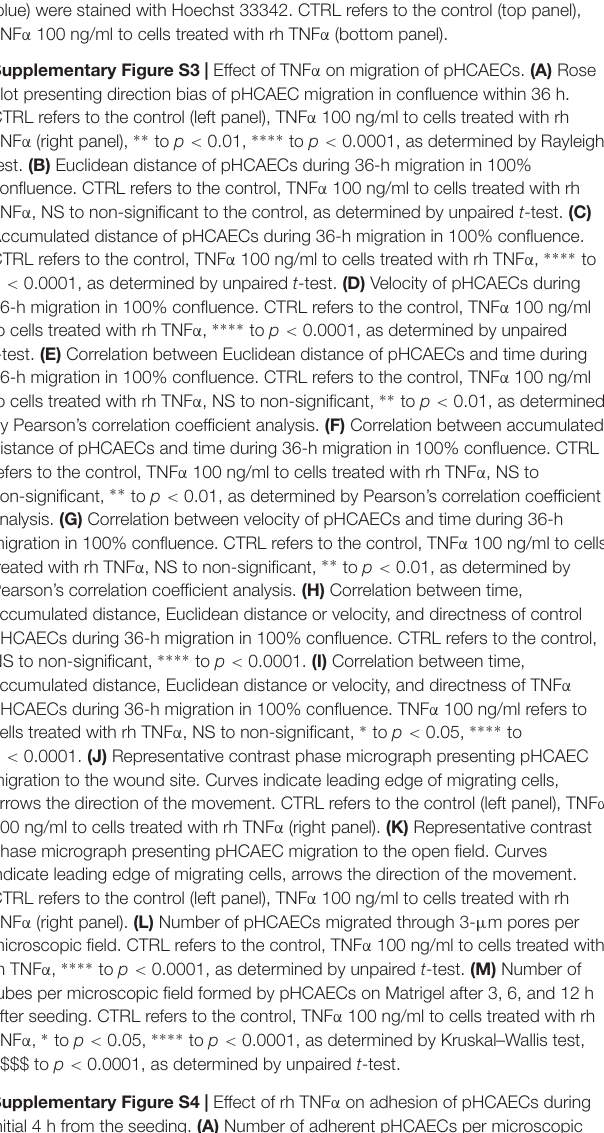
Supplementary Figure S4 | Effect of rh TNF α on adhesion of pHCAECs during initial 4 h from the seeding. (A) Number of adherent pHCAECs per